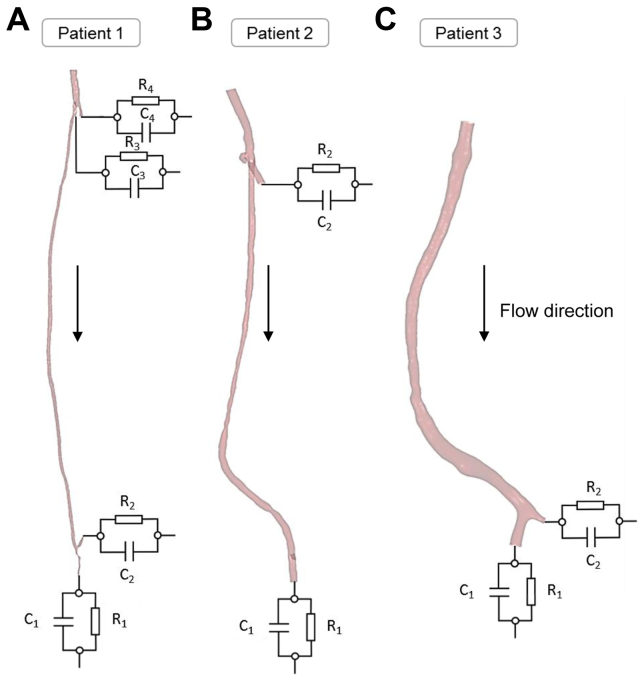
Boundary conditions at the outlets were modeled using RC elements. A, Patient 1, femoral-distal bypass. B, Patient 2, femoral-popliteal bypass. C, Patient 3, femoral-popliteal bypass.